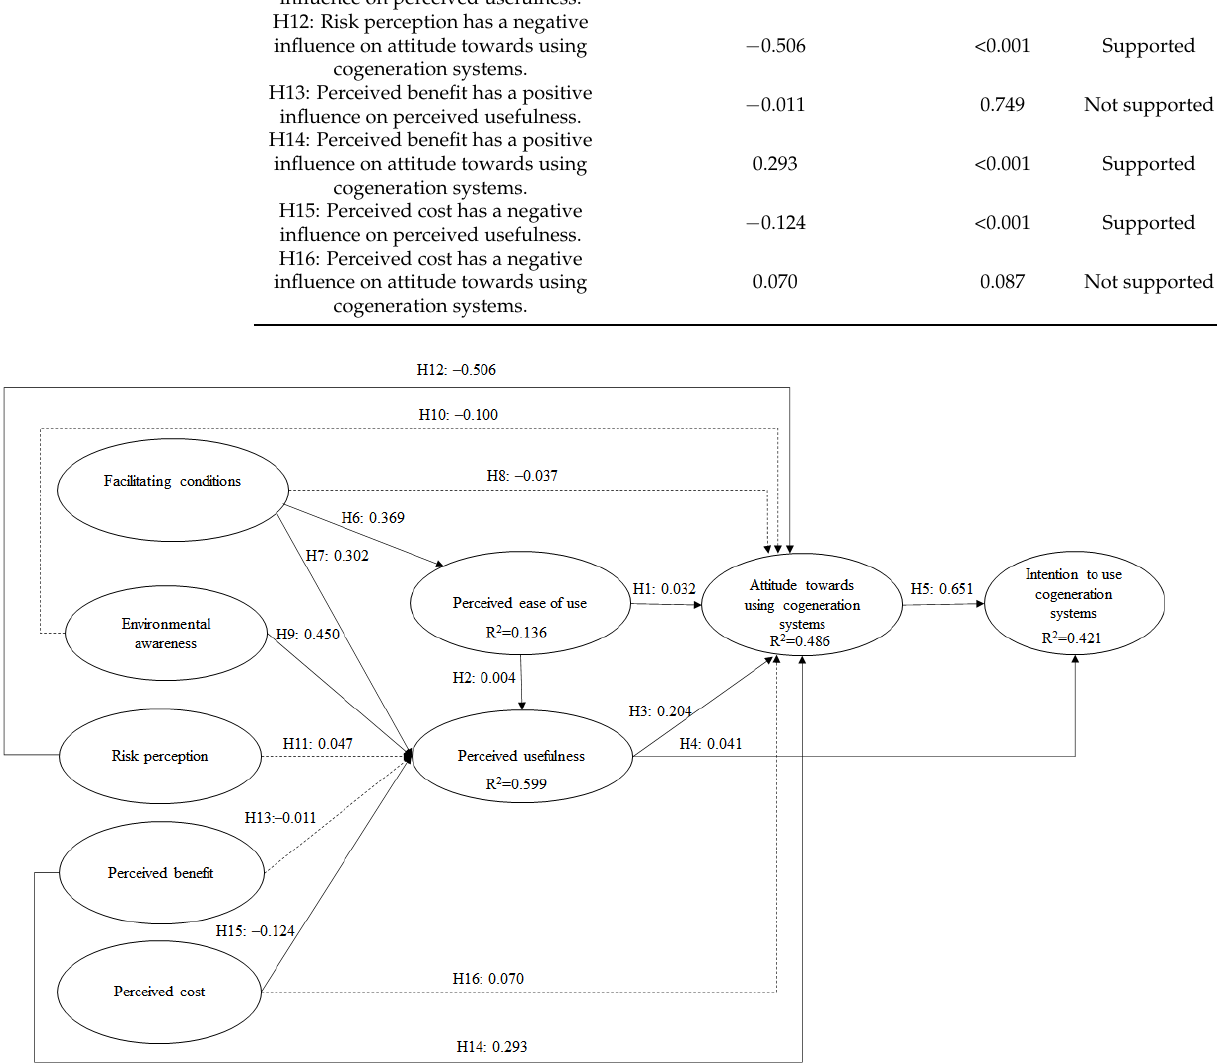
Figure 3. Results of the structural model (i.e., CoSAM) assessed by SEM. Dotted lines indicate non-significant paths, while solid lines denote significant paths.